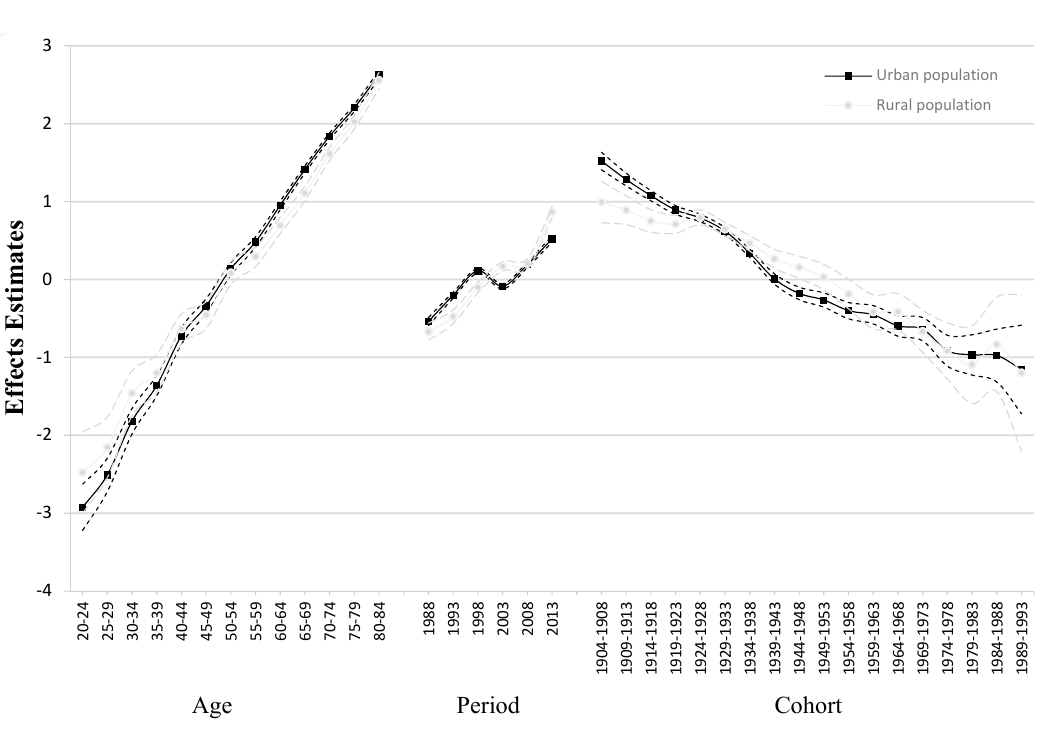
Figure 5. Age-period-cohort effects on IHD mortality in China.